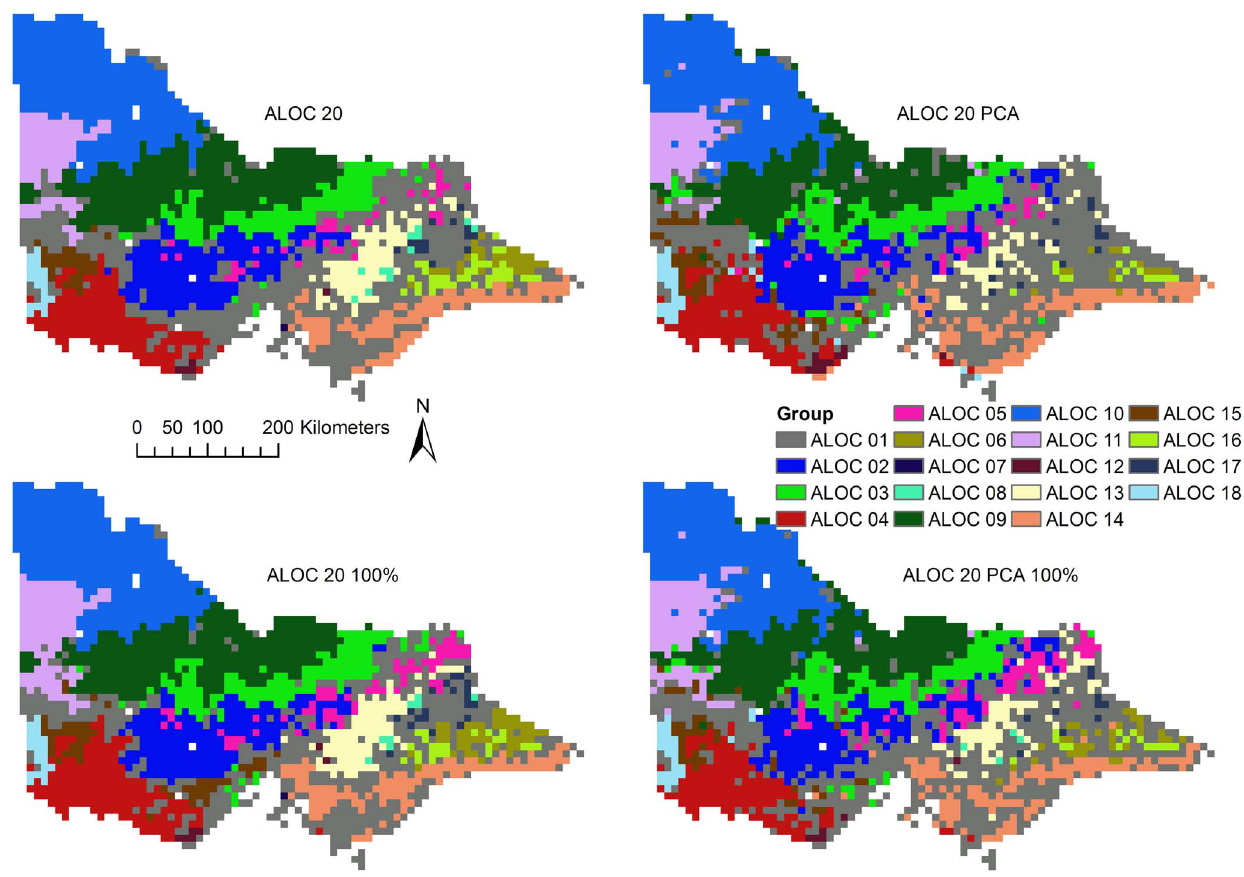
Figure 6. Results of the ALOC 20 (10 km) classifications. Top row - ALOC 20 and ALOC 20 PCA; Bottom row - ALOC 20 (100%) and ALOC 20 PCA (100%). Note that not all ALOC clusters are present in the final classifications. Colours represent each of the ALOC non-hierarchical clusters. Similar colours and cluster numbers do not necessarily represent related groups.